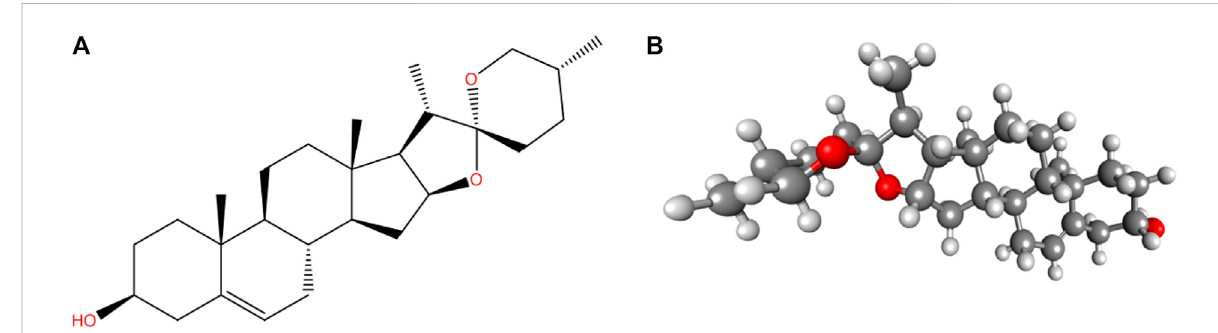
FIGURE 1 Structure of Diosgenin (A) 2D and (B) 3D (ball and stick). PubChem CID: 99474, Molecular Formula: C 27 H 42 O 3 , Synonyms: Nitogenin, UNII- K49P2K8WLX, (3 β , 25R)-spirost-5-en-3-ol, Molecular Weight: